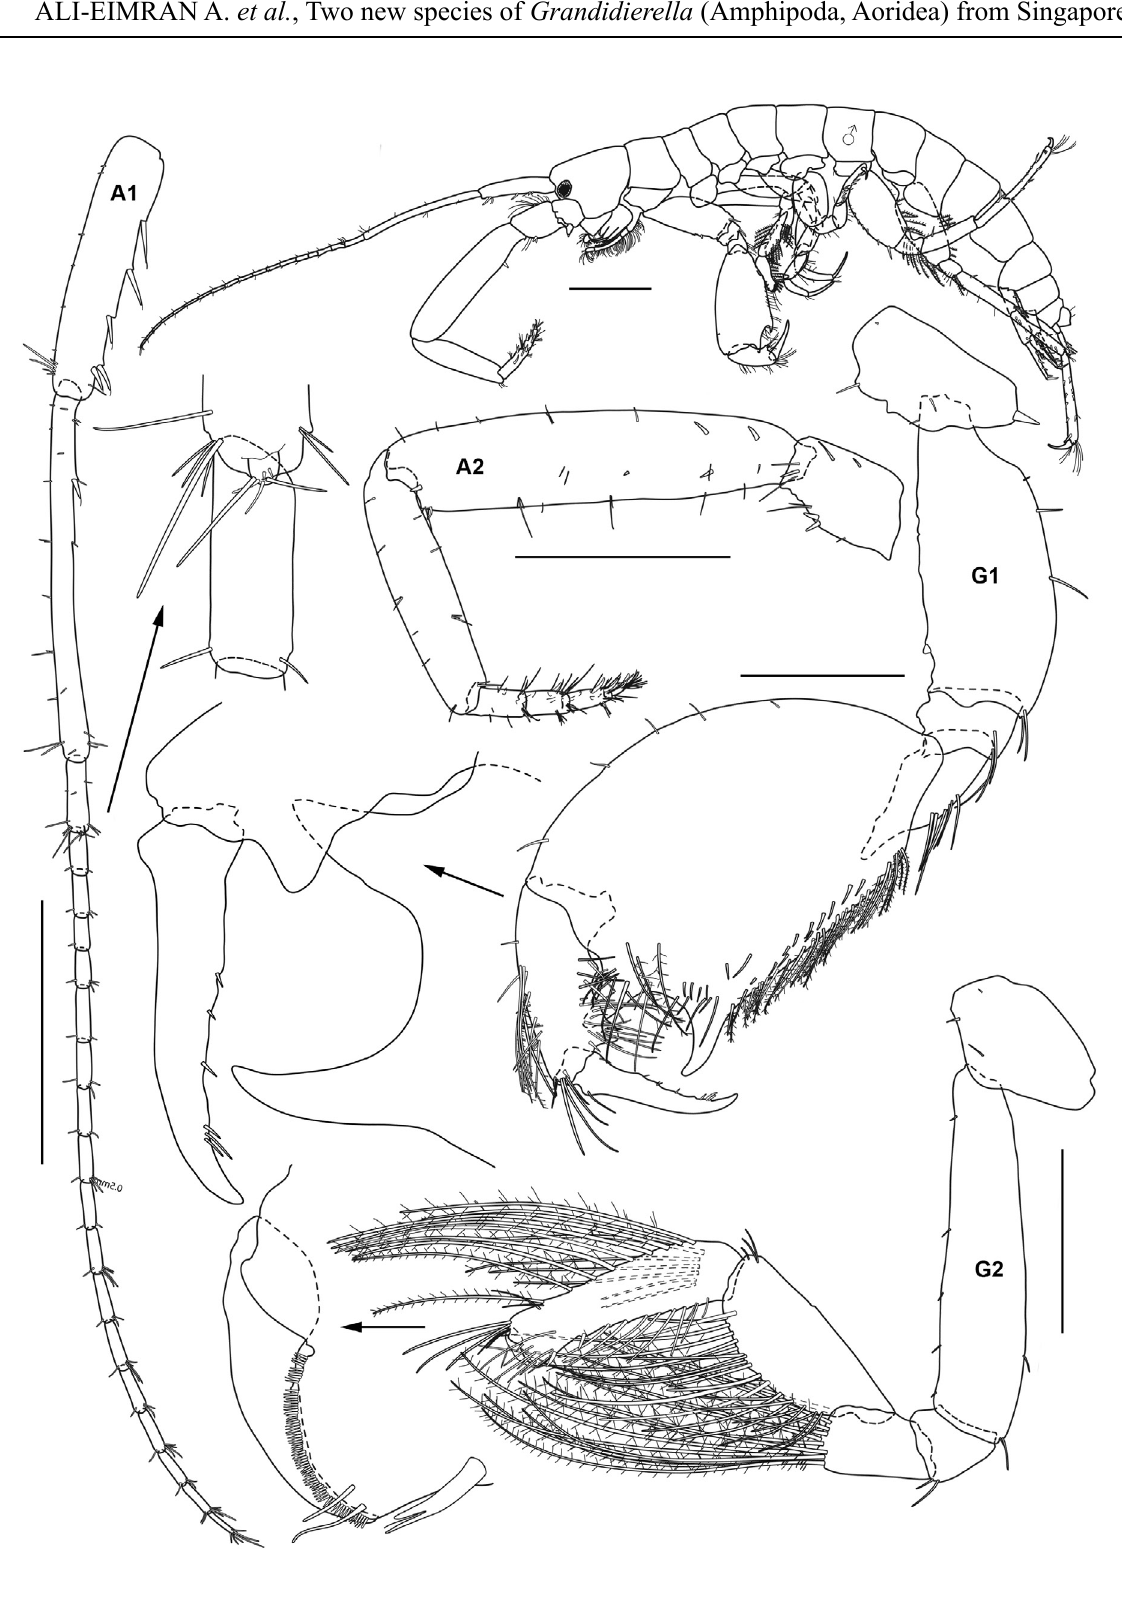
Fig. 12. Grandidierella sungeicina sp. nov., holotype, ♂ (ZRC 2018.0490). Scale bars: A1, A2 = 0.1 mm; remaining scales = 0.5